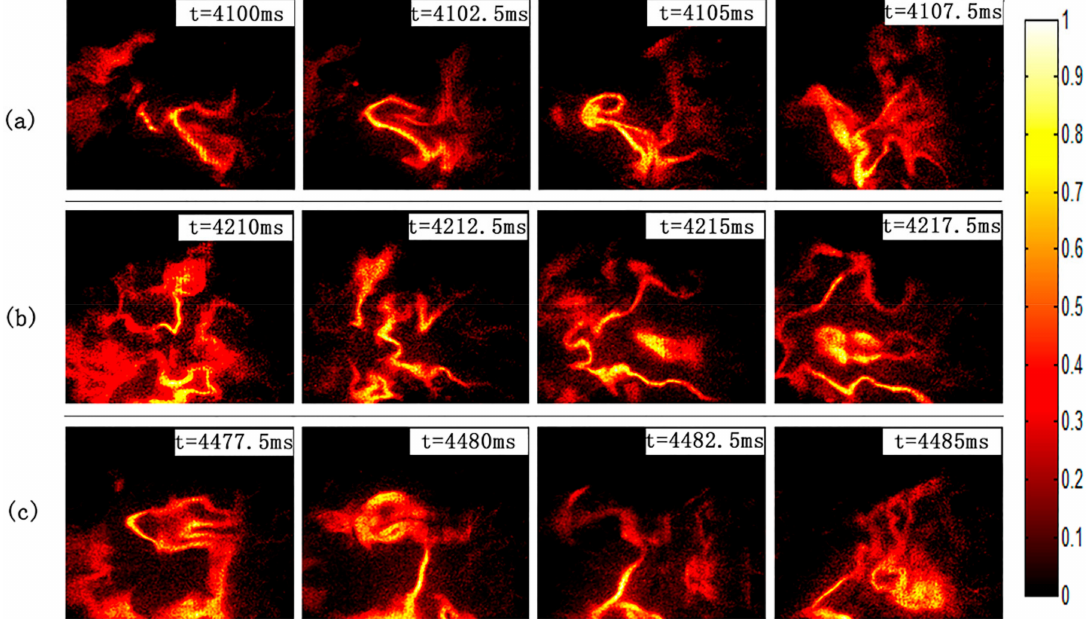
Figure 7. Selected sequences of OH-PLIF images about flame evolution following autoignition ( a – c ). Images in time-sequence from left to right only, with 2.5 ms between consecutive frames, field of view = 110 mm × 110 mm. The oxygen concentration is 33%. The excess air coefficient α = 1.652. The oxygen consumption is 103 L/min, and the total gas flow is 676 L/min.